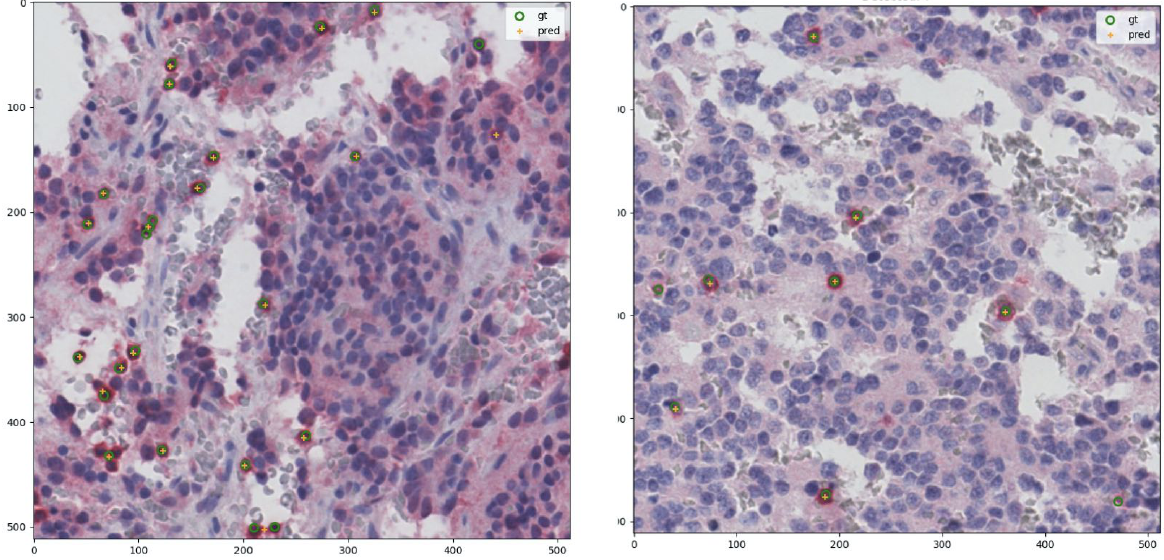
Figure 6. Examples of lymphocytes detection obtained through postprocessing of predicted density maps on the original tiles of Figure 5. gt : ground truth after postprocessing, pred : prediction.